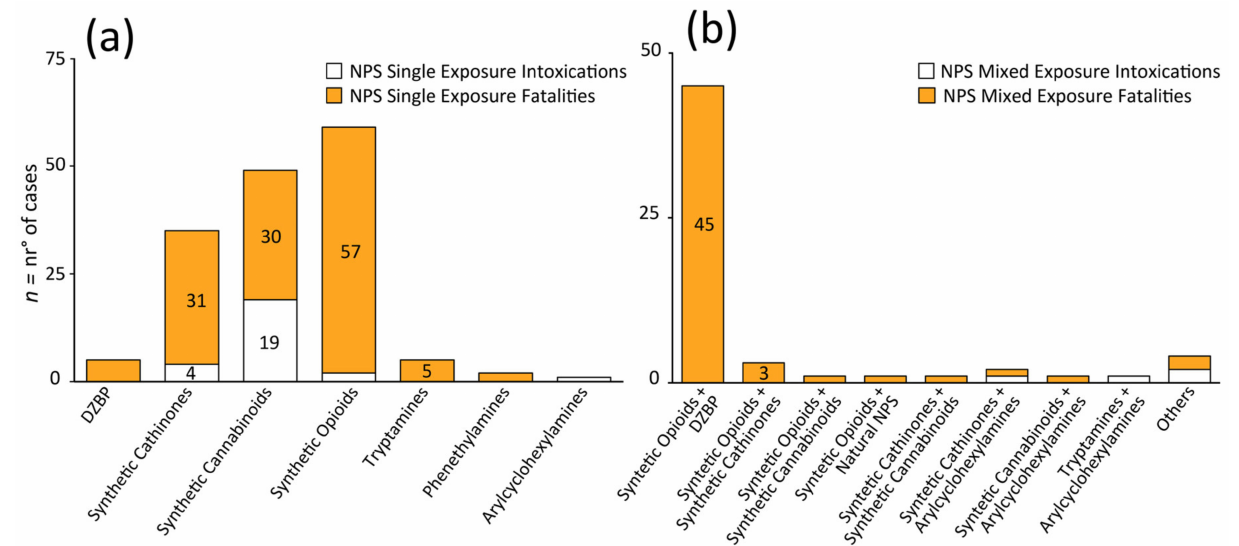
Figure 3. Number of NPS single intoxications and fatalities. ( a ) NPS mixed intoxications and fatalities